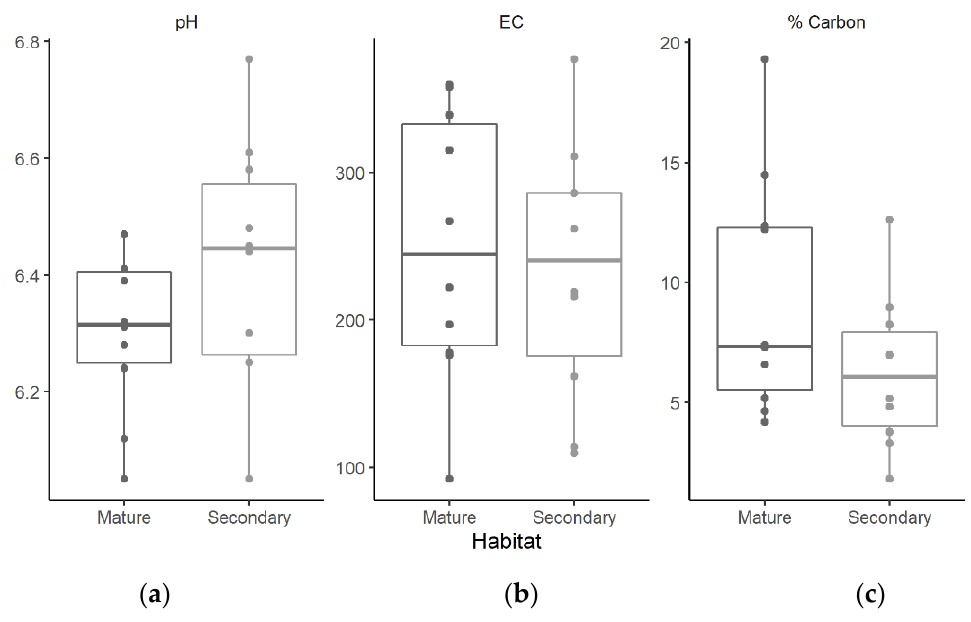
Figure 2. Variation in soil pH ( a ), electrical conductivity ( b ), and % organic carbon ( c ) in mature continuous forests and secondary forests in southern Mexico.